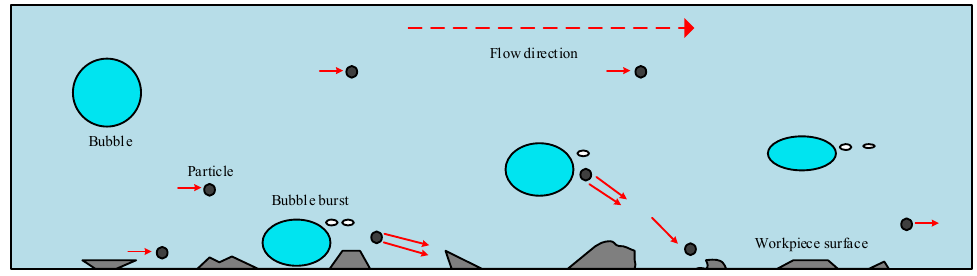
ff ect of bubble bursting on Figure 1. The accelerating effect of bubble bursting on particles. Figure 1. The accelerating e